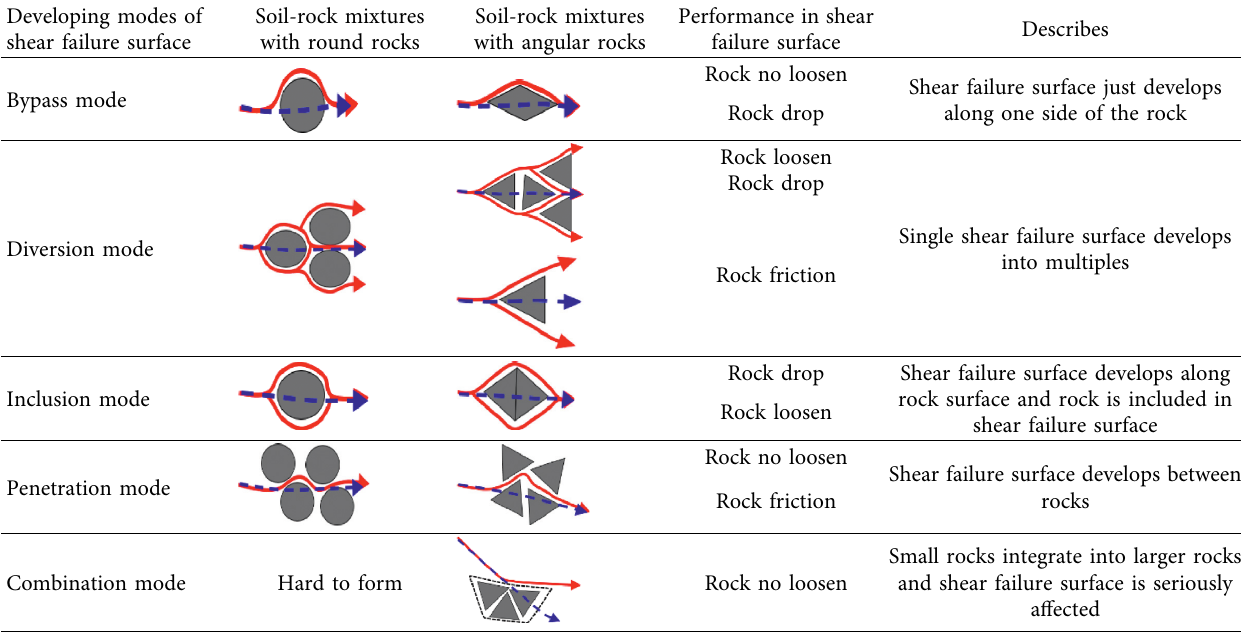
Table 1: Developing modes of shear failure